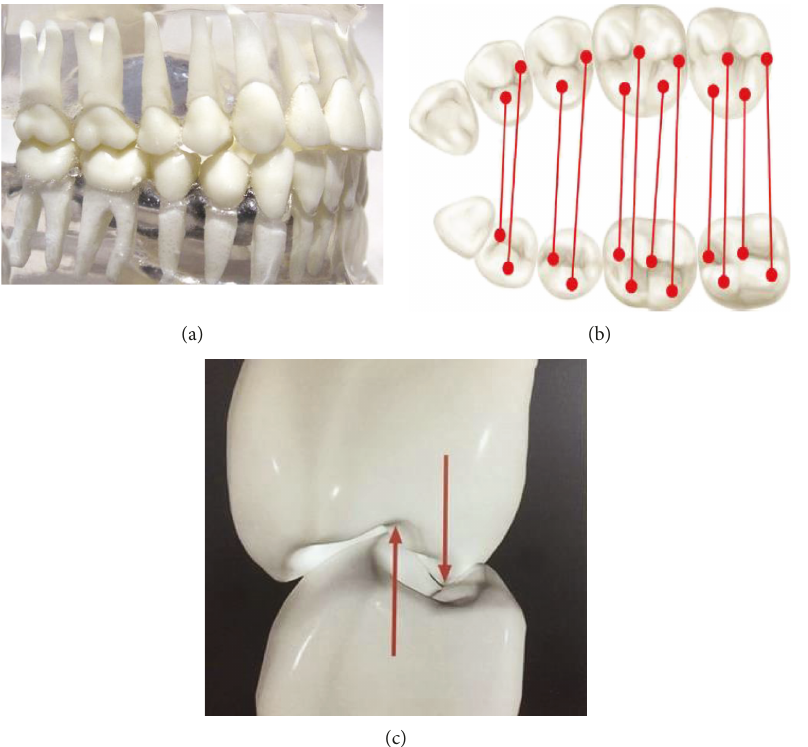
Figure 1: Harmonious relationship of dental morphology. (a) Dental occlusion, (b) points where the upper teeth make contact with the lower teeth, according to their morphology, and (c) detail of occlusal assembly between premolars.